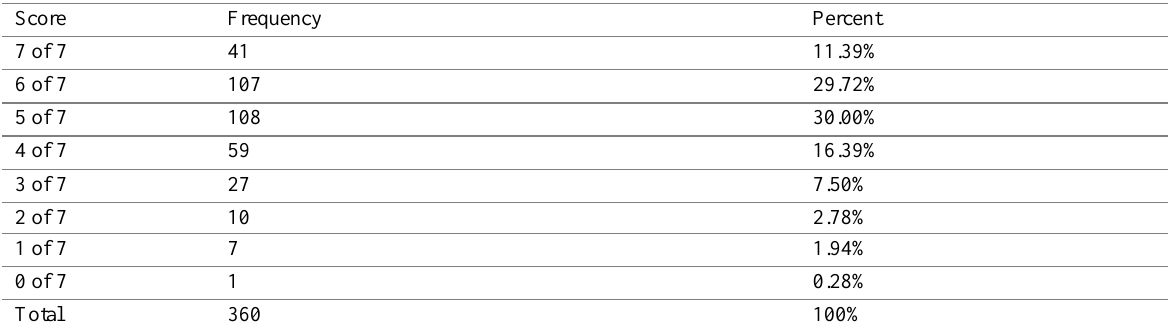
Table 2: Level of Financial Literacy of HEI Teachers in Region 1.